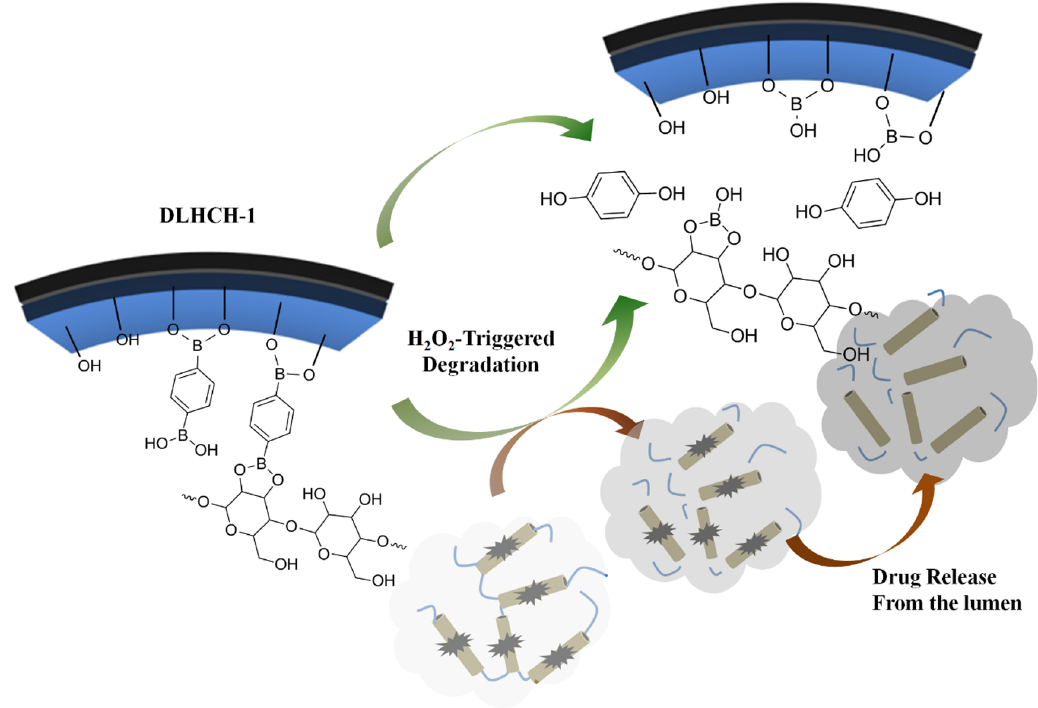
Figure 12: The procedures of H 2 O 2 -responsive drug delivery system conducted by our group [36]